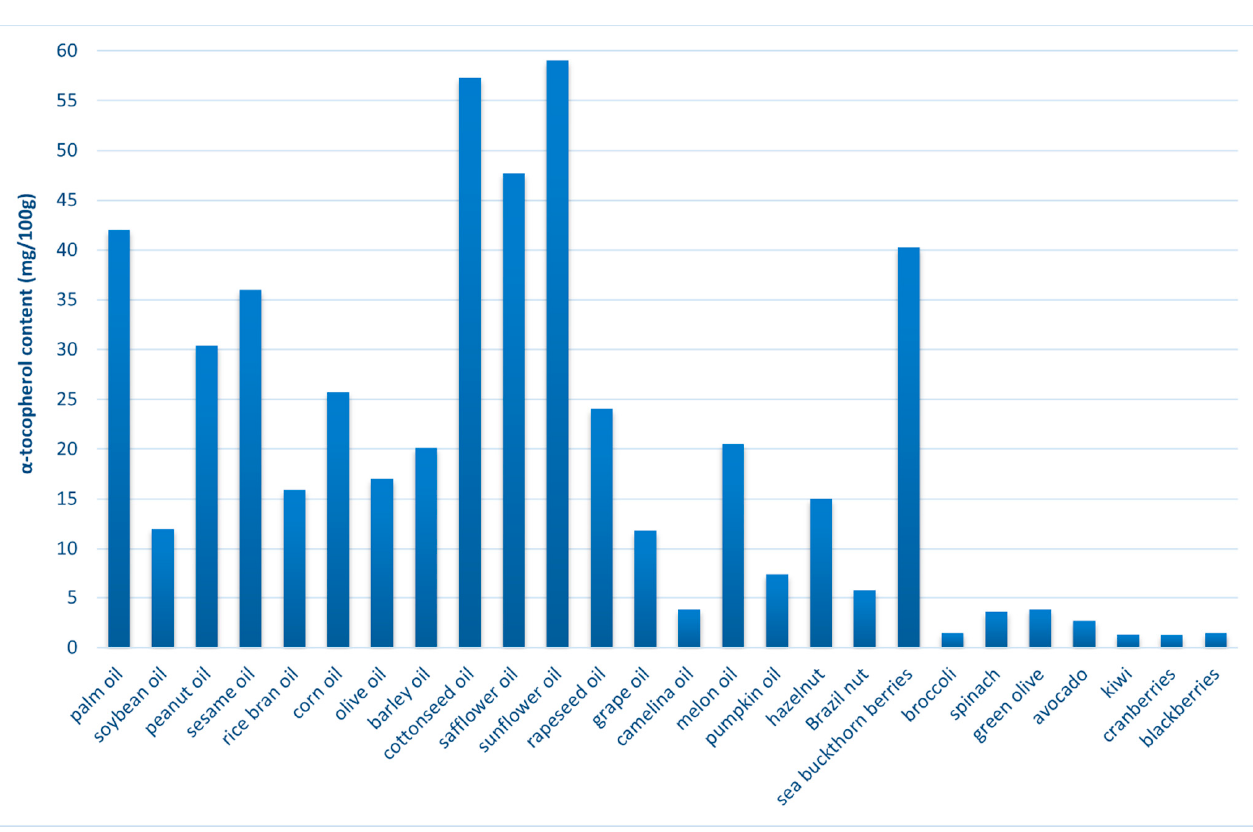
Figure 3. Selected plant sources of α -tocopherol [70,75–78].